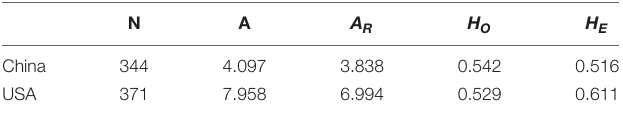
TABLE 3 | Population genetic parameters of Chinese and American Spartina alterniflora. N A A R H O H E China 344 4.097 3.838 0.542 0.516 371 7.958 6.994 0.529 0.611 N, the number of analyzed samples; A, average value of the number of alleles among Chinese or American populations of S. alterniflora; AR, allelic richness, average allele number among Chinese or American populations of S. alterniflora; HO and HE, average value of observed and expected heterozygotes among Chinese or American populations of S. alterniflora,